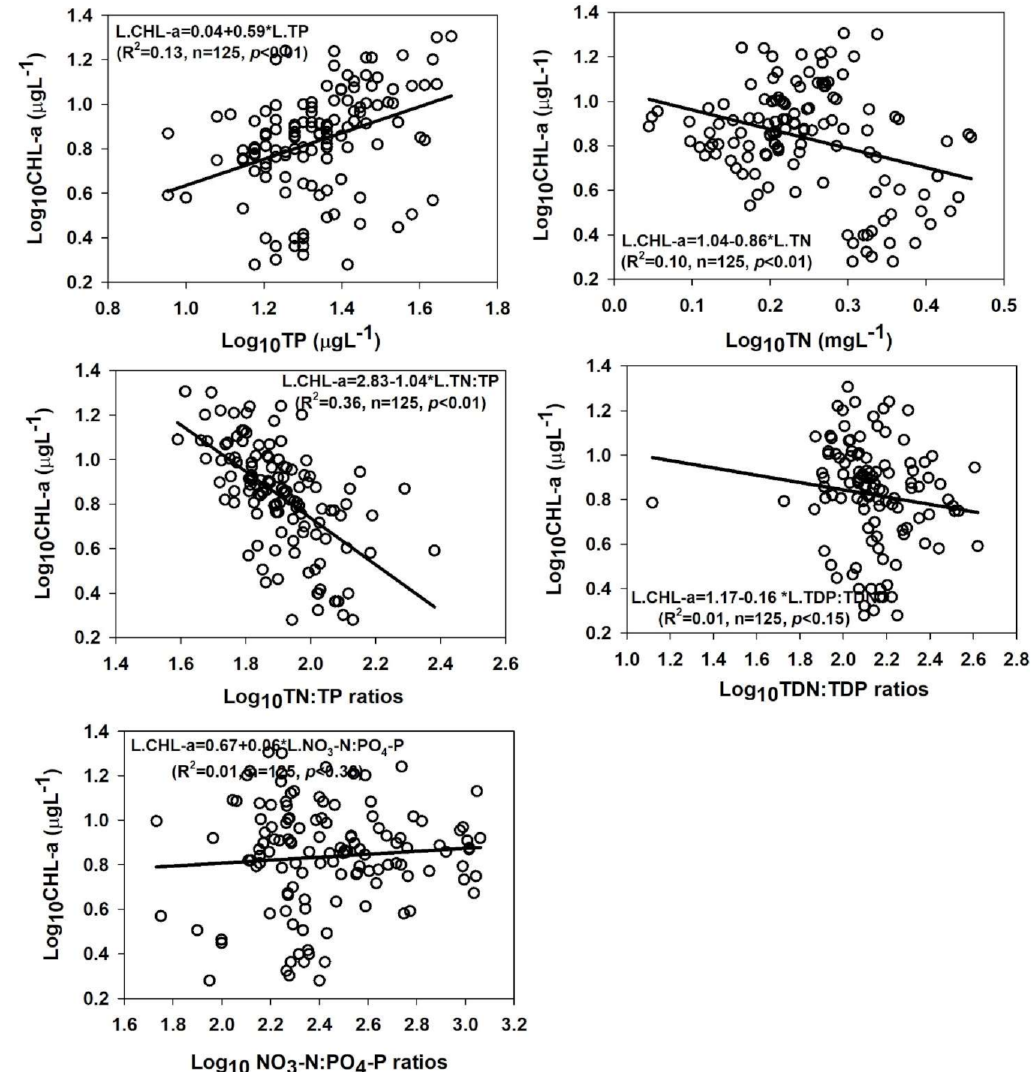
Figure 6. Empirical relationships between chlorophyll-a, nutrients, and their ambient ratios. CHL-a: chlorophyll-a; TP: total phosphorus; TN: total nitrogen; TDN: total dissolved nitrogen; TDP: total dissolved phosphorus; NO 3 -N: nitrate-nitrogen; and PO 4 -P: